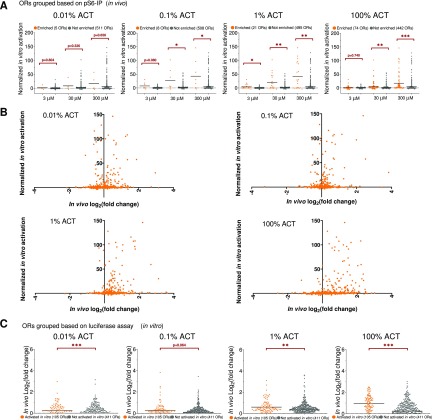
In vivo OR enrichment correlates with the in vitro activation data. A, In vitro Hana3A cell lines cAMP-mediated reporter data for 516 out of the 1088 pS6-IP-Seq mapped intact ORs are classified into in vivo pS6-IP-Seq ACT enriched (orange, FDR corrected p < 0.05 and log2 fold change > 0) and not enriched groups (gray, FDR corrected p > 0.05 or log2 fold change < 0). In vitro normalized fold increase in luciferase signals were plotted for each OR groups across four ACT concentrations; 100% is based on the fold of increase of Olfr1126 activated by 300 μM ACT; 0% is determined by the fold of increase of empty rho-pCI vector stimulated with 3 μM ACT. Black bars represent mean; *p < 0.05, **p < 0.01, ***p < 0.001 by Mann–Whitney test (in vivo enriched ORs compared with not enriched ORs). B, Individual pS6-IP-Seq ORs at 0.01%, 0.1%, 1%, and 100% starting concentrations of ACT have their FDR corrected p values plotted against in vitro activation data. Green dotted line indicates FDR corrected p = 0.05 line (ORs to the right have FDR corrected p < 0.05, ORs to the left have FDR corrected p > 0.05). Red and blue lines indicate mean in vitro activation values for in vivo enriched and not enriched ORs. C, In vivo pS6-IP-Seq fold enrichment was plotted for each OR groups across four ACT concentrations. ORs are classified based on in vitro cAMP-mediated reporter data into activated (orange, fold luciferase induction at 300 μM ACT > 2.33) and not activated groups (gray, fold luciferase induction at 300 μM ACT < 2.33). Black bars represent mean; **p < 0.01, ***p < 0.001 by Mann–Whitney test (in vitro enriched ORs compared with not enriched ORs). See Extended Data Figures 4-1, 4-2 for in vitro data supporting this figure.